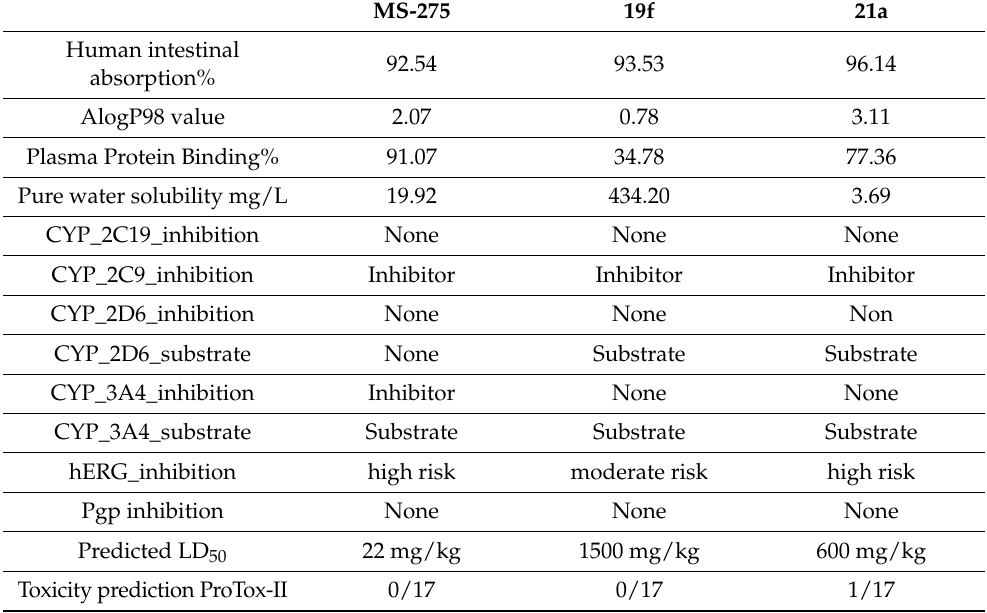
Table 4. In silico ADME and Tox prediction for the most promising candidates 19f and 21a as well as the reference inhibitor MS-275. For predicting the properties PreADMET (https://preadmet.bmdrc. kr/admetox/ accessed date 10 Novermber 2021) and ProTox-II (https://tox-new.charite.de/protox_ II/ accessed date 10 Novermber 2021) web applications were